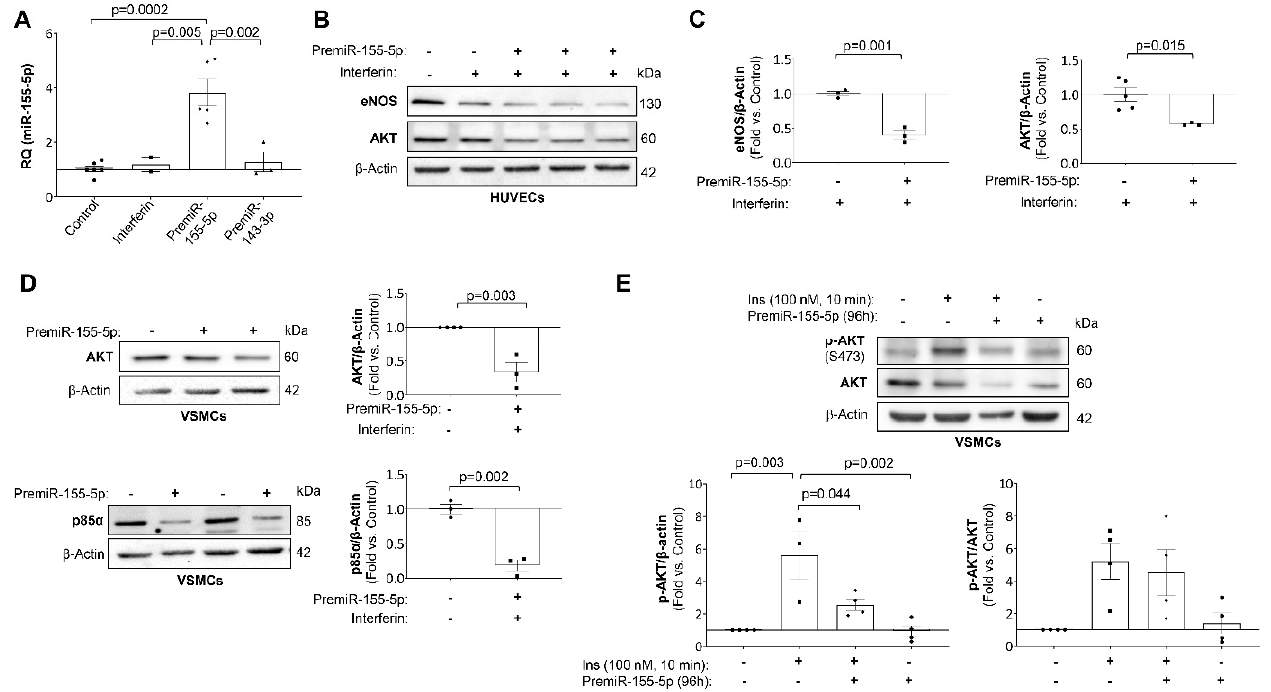
Figure 3. miR-155-5p reduced AKT expression and its activation in vascular cells. ( A ) Relative quantification of the expression levels of miR-155-5p in transfected HUVECs. ( B ) Representative Western blot images of AKT and eNOS expression and ( C ) their quantification in transfected HUVECs. ( D ) Representative Western blot images of the expression of p85 α and AKT ( left ) and their quantification ( right ) in transfected HUVECs. ( E ) Representative Western blot images of AKT phosphorylation in response to insulin stimulation in transfected VSMCs ( upper ) and their quantification ( lower ). HUVECs = human umbilical vein endothelial cells; VSMCs = vascular smooth muscle cells; eNOS = endothelial nitric oxide synthase; AKT = protein kinase B; p85 α = phosphoinositide-3-kinase regulatory subunit 1; Ins = insulin. All the in vitro experiments were performed in triplicate.